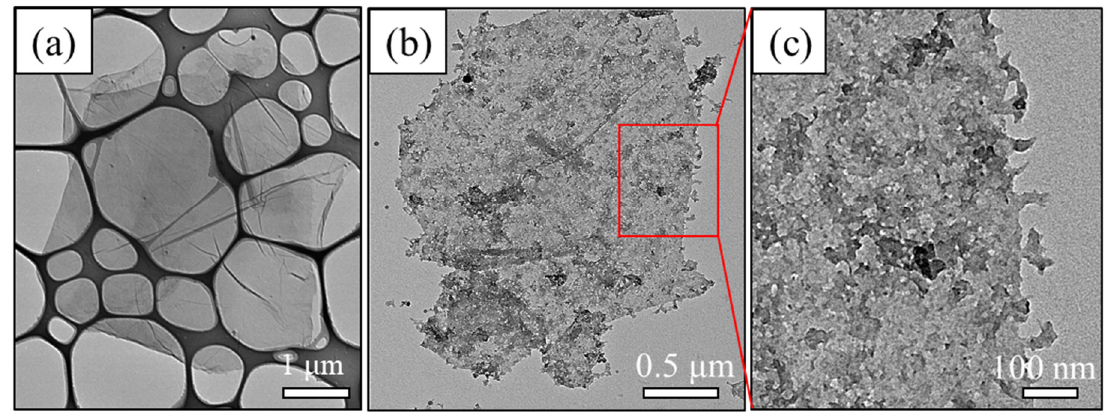
Figure 2. TEM images of ( a ) pure GO and ( b , c ) GO/PDPA microsheet composites.